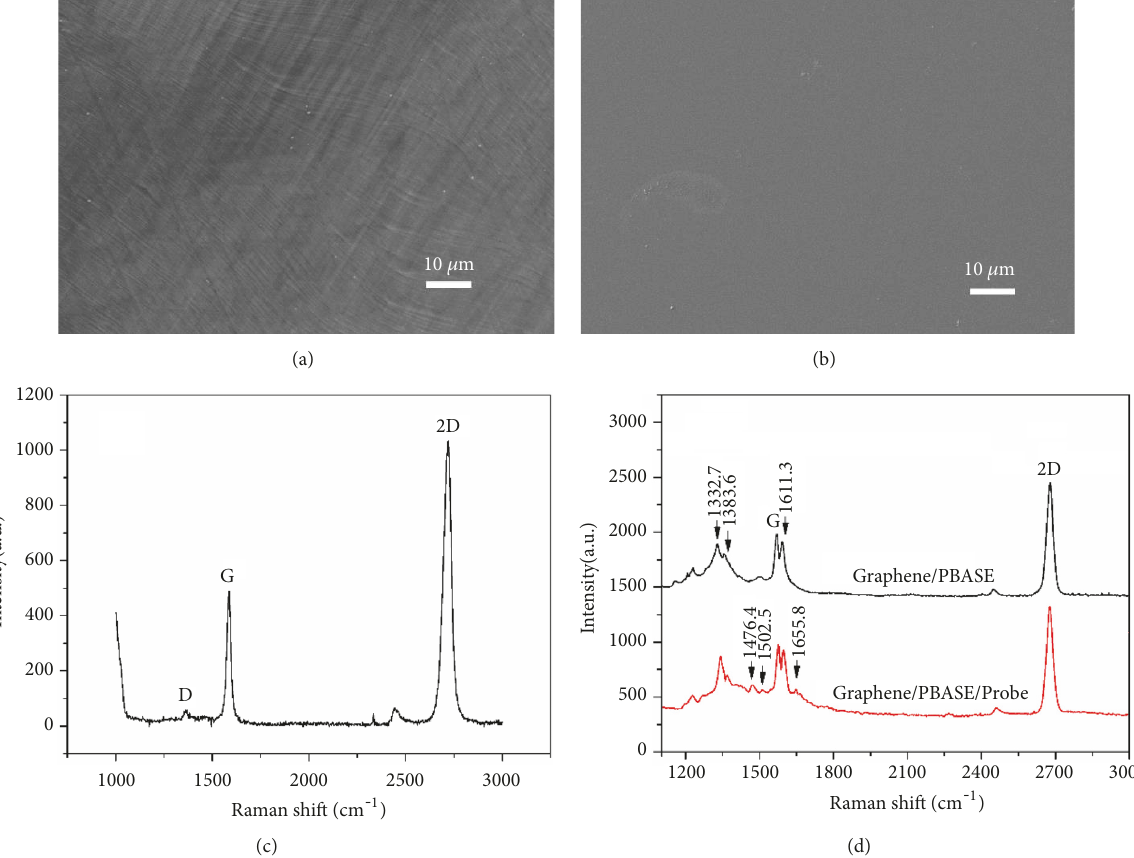
Figure 2: (a) SEM image of the as-grown graphene on the copper foil. (b) SEM image of graphene on glass substrate. (c) Raman spectrum of the graphene on glass substrate. (d) Raman spectra of graphene in the process of